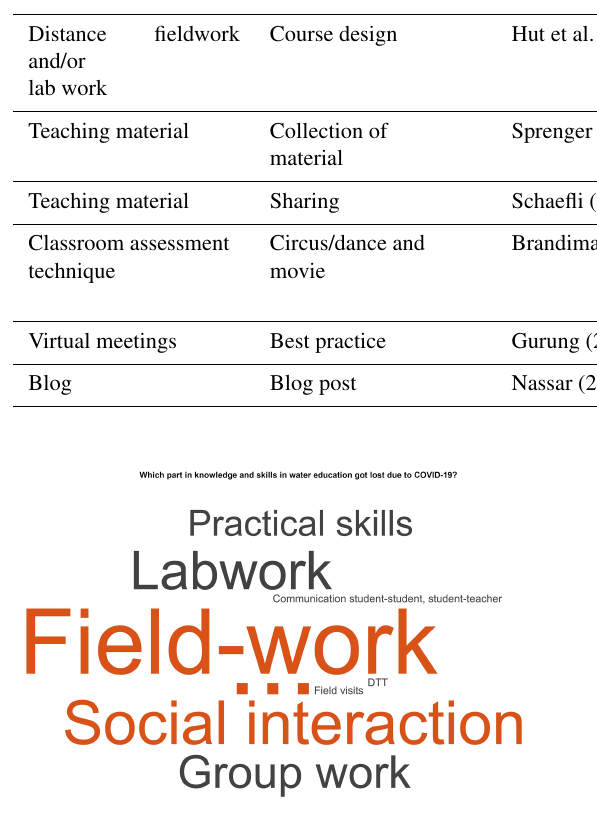
Figure 8. Which part in knowledge and skills in water education got lost due to COVID-19, indicated by the respondents. The larger the font, the more respondents indicated using the measure or aid (multiple answers were